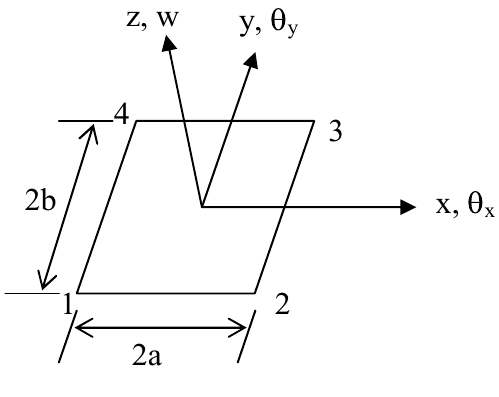
Fig. 2. Quadrilateral plate